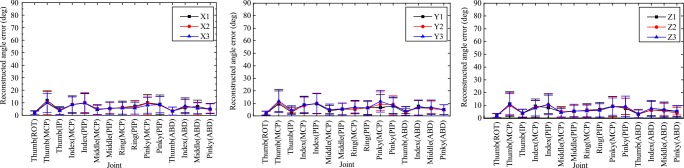
Reconstructed angle error distributions by first four PCs of hand postures (15DOF).